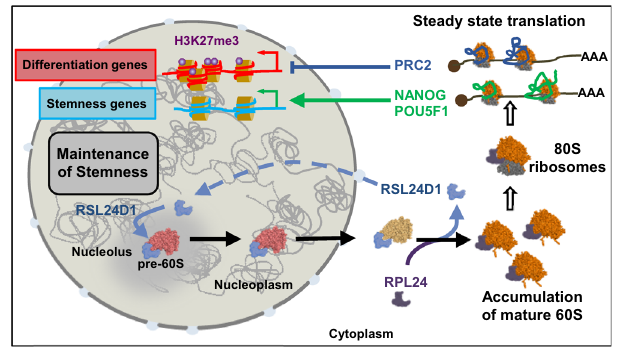
Fig.7|ModeldescribingthefunctionsofRSL24D1intheLSUbiogenesisandin thetranslationalregulationofkeypluripotencyanddevelopmentalprograms in mouse ESCs. Some of the content displayed in this fi gure were created with BioRender.com, under full licence